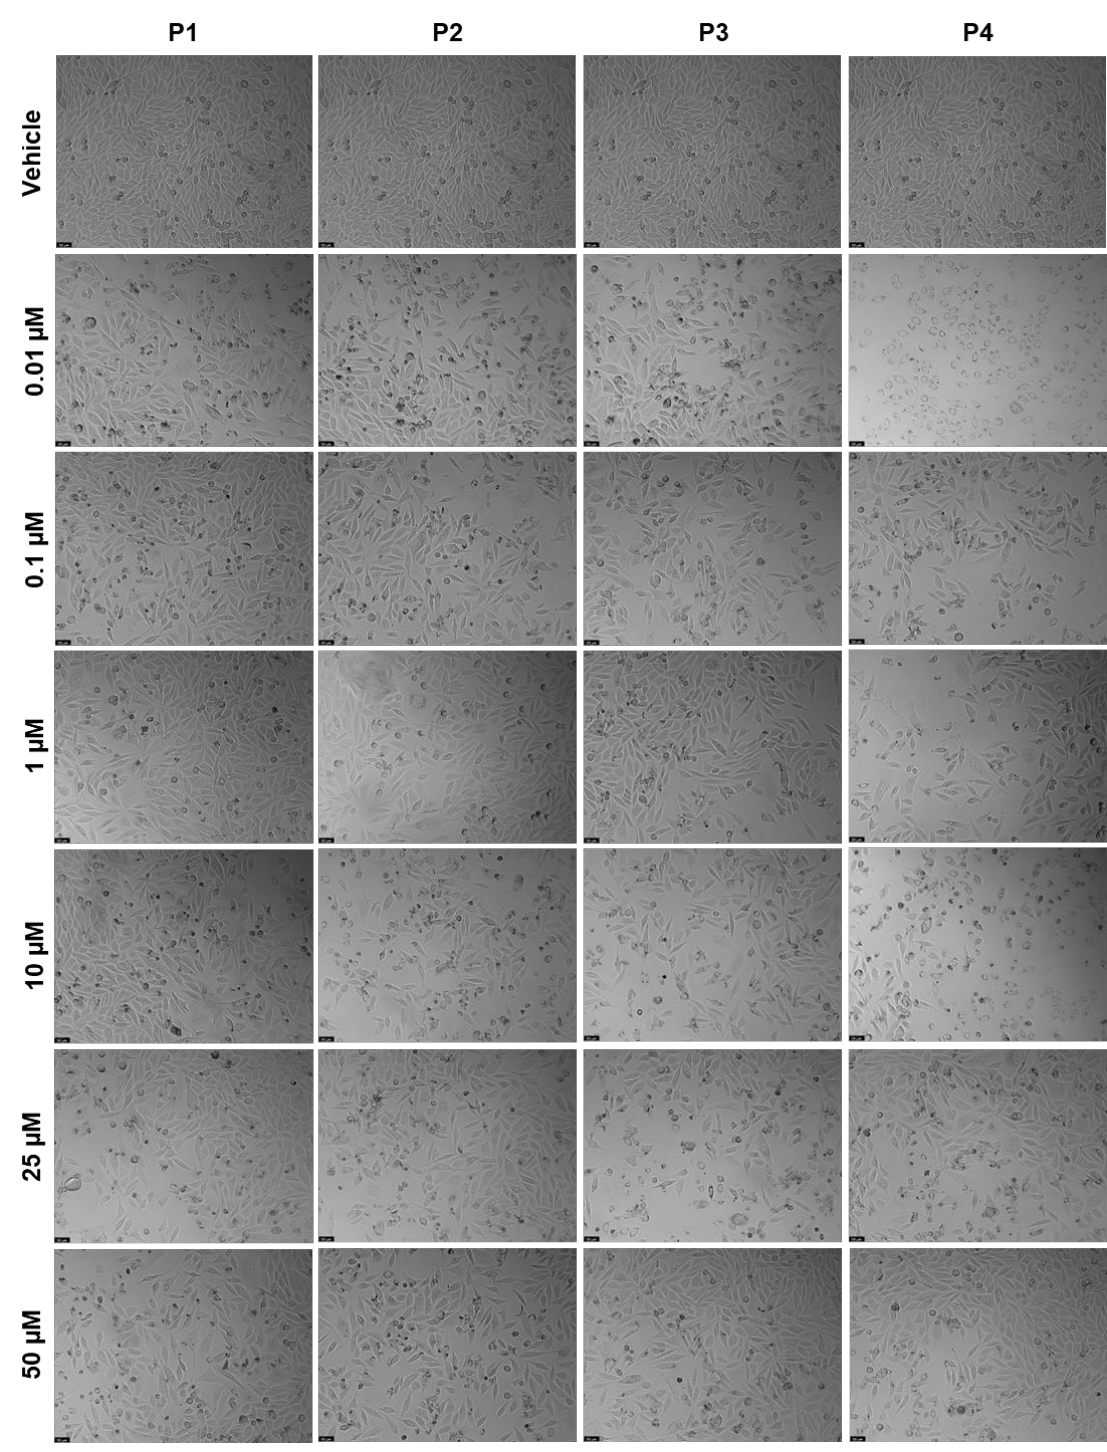
Figure 14. Morphological evaluation of PC-3 after exposure to increasing concentrations of P1 – P4 (0.01 – 50 μM) for 48 h. Control cells were treated with the vehicle (0.01% DMSO). These images are representative of three independent experiments. Scale bar is 200 μM.